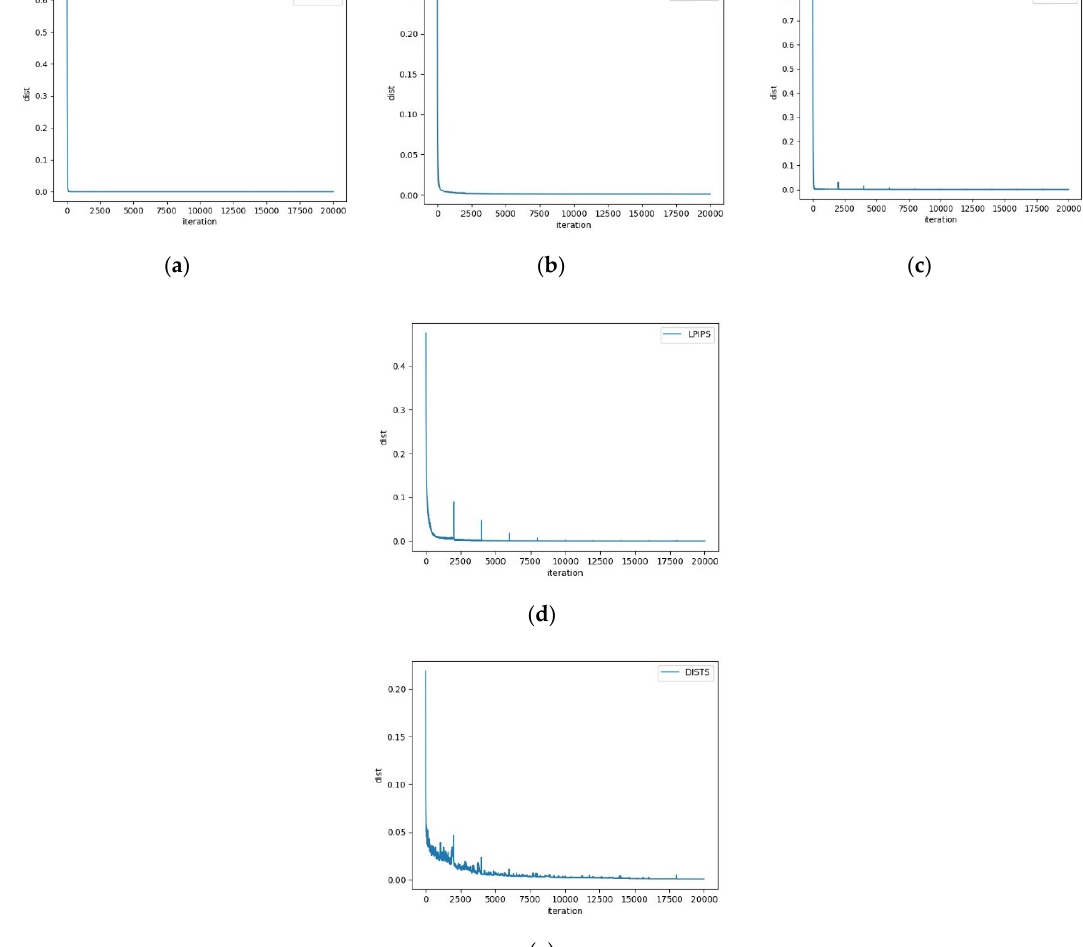
Figure 8. Convergence curves of the whole iterations in Gorge restoration based on different IQA models. ( a ) SSIM; ( b ) FSIM; ( c ) MSE; ( d ) LPIPS; ( e ) DISTS.